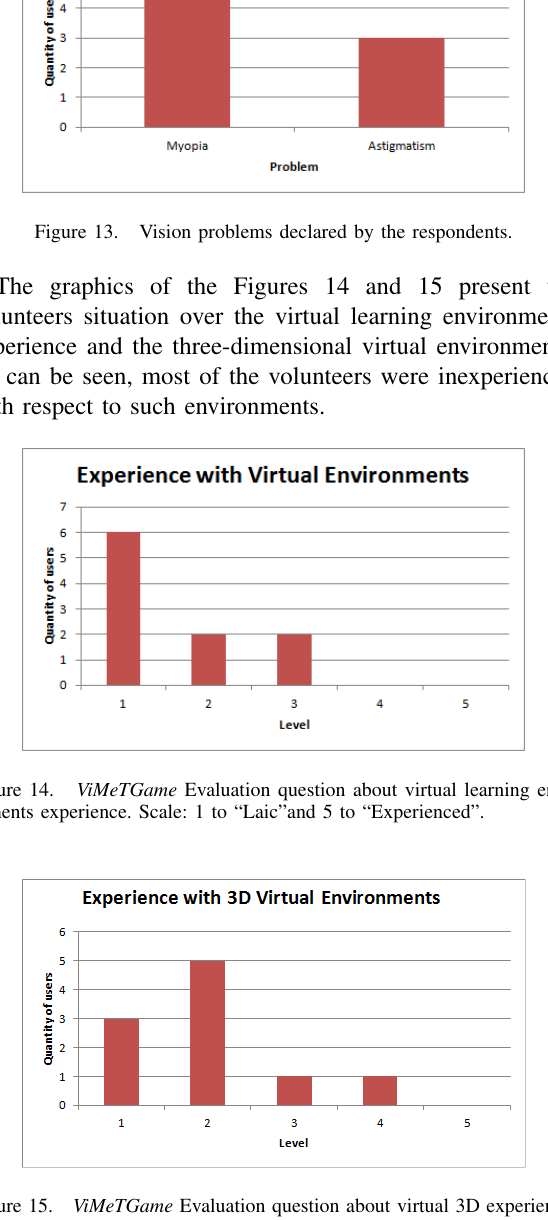
Figure 15. ViMeTGame Evaluation question about virtual 3D experience. Scale: 1 to “Laic”and 5 to “Experienced”. About 80% of the respondents claim not to have a knowl- (the lowest level marked was 2) belong to health area. With